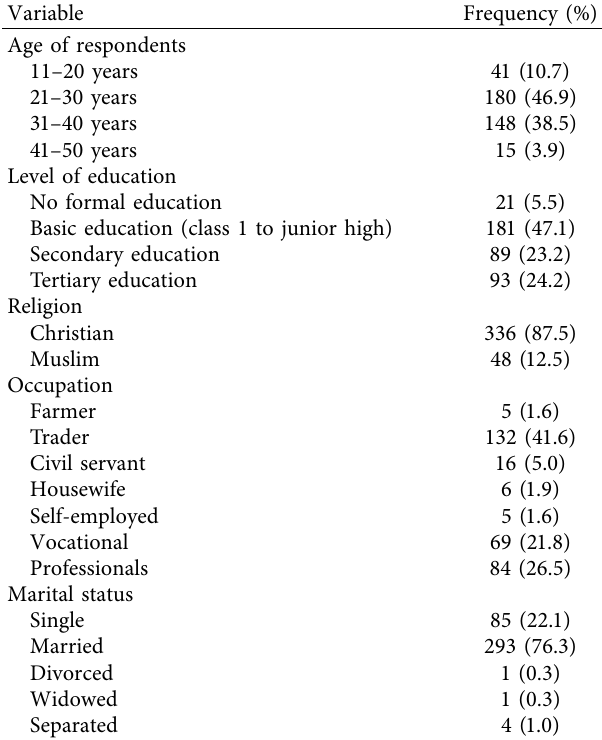
Table 2: Sociodemographic characteristics of